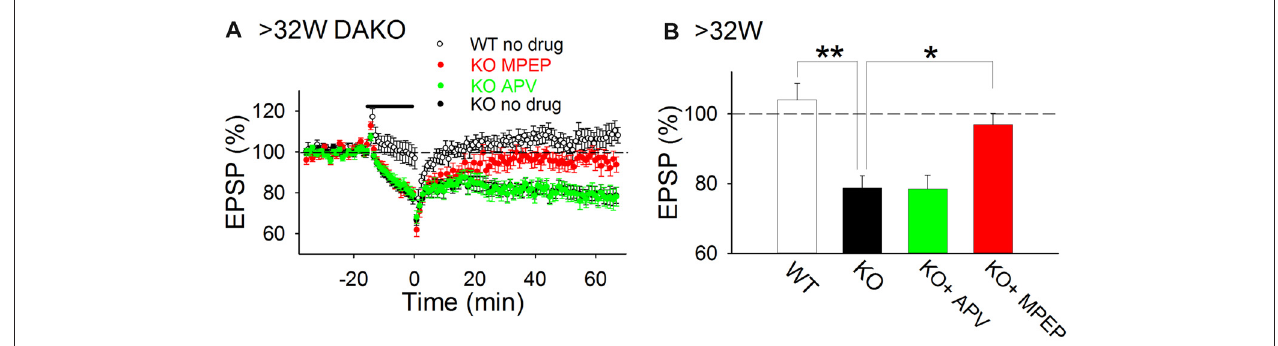
FIGURE 4 | mGluR5-dependent LTD is aberrantly induced in adult DAKO mice. (A,B) Average time course (A) and summary (B) of LTD experiments in WT ( n = 12 from four mice) and DAKO mice (control, n = 21 from eight mice; D-APV, n = 12 from three mice; MPEP, n = 16 from eight mice) at > 32 weeks postnatal ( ∗ p < 0.05; ∗∗ p < 0.01; one-way ANOVA with Tukey–Kramer test).